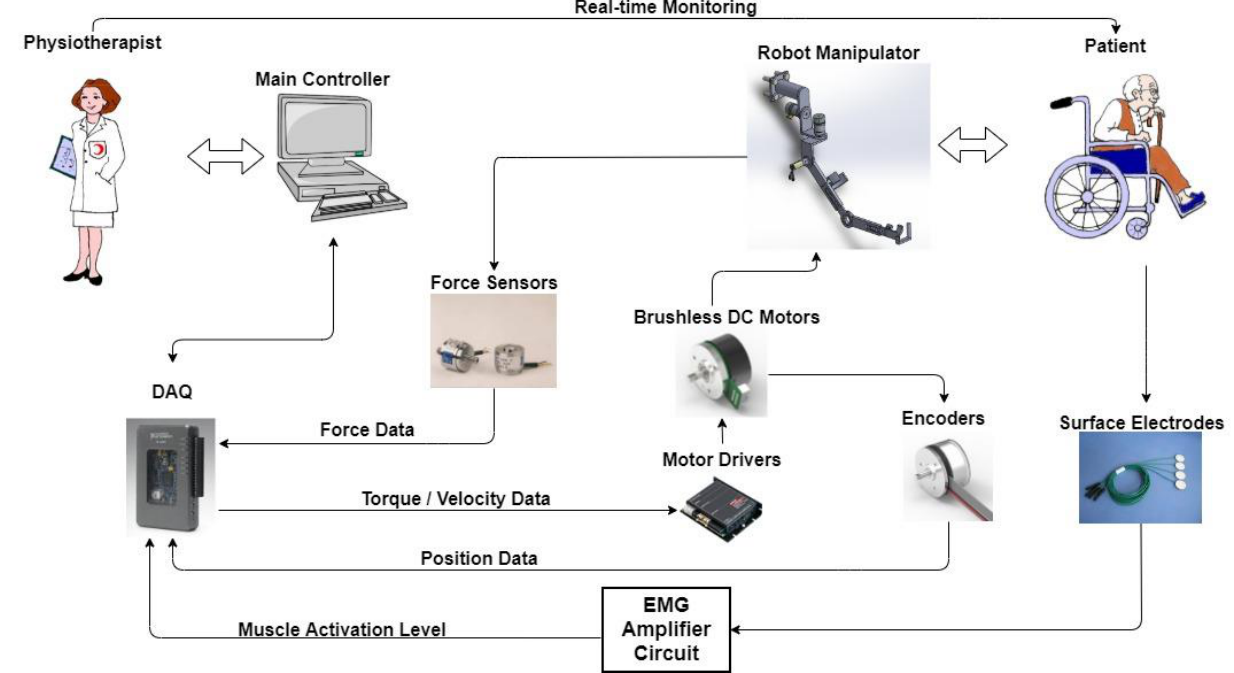
Figure 3. Block diagram of system